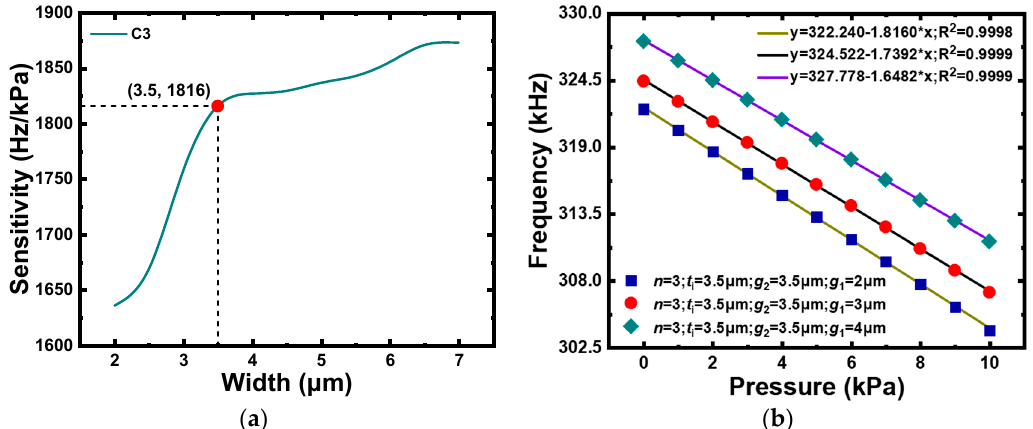
Figure 9. ( a ) Pressure sensitivity of C3 with different groove widths ( n = 3, g 1 = 3.5 µ m, g 2 = 3.5 µ m ). ( b ) Resonance frequency of C3 with different adjacent groove spacing ( n = 3, g 2 = 3.5 µ m, t i = 3.5 µ m ).